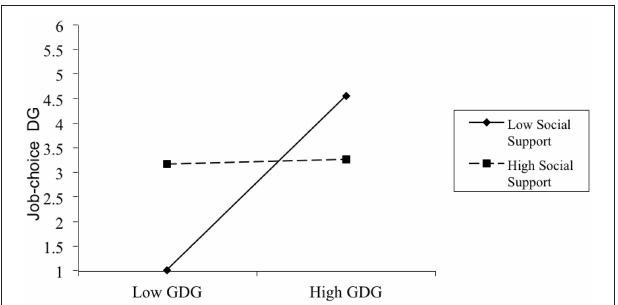
FIGURE 3 | Interaction between GDG and social support manipulation on job-choice DG. Note: low = 1 SD below the mean; high = 1 SD above the